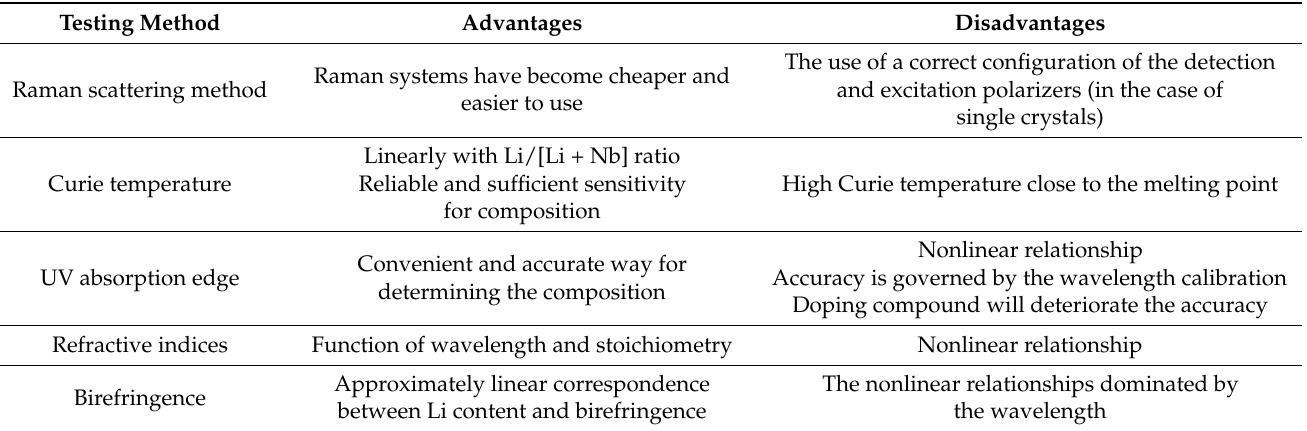
Table 2. Testing method of Li composition for LiNbO 3